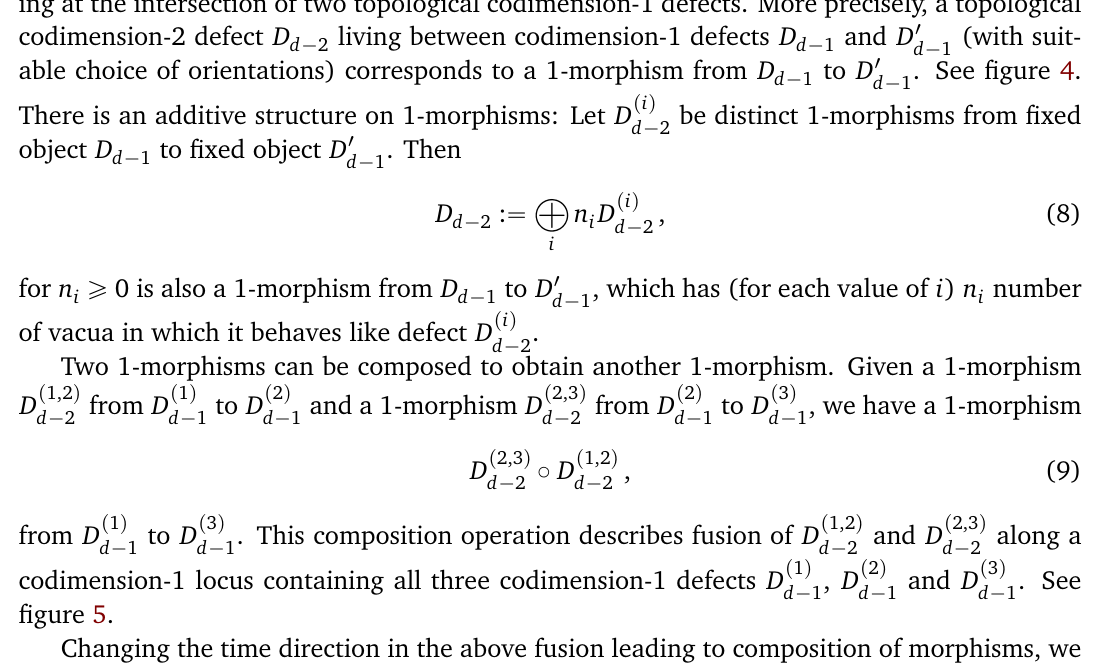
Figure 4: A 1-morphism D p 1,2 q defect living between codimension-1 topological defects D p 1 q the direction of the morphism, we need to pick a “time” direction, which is taken to run from bottom to top of the